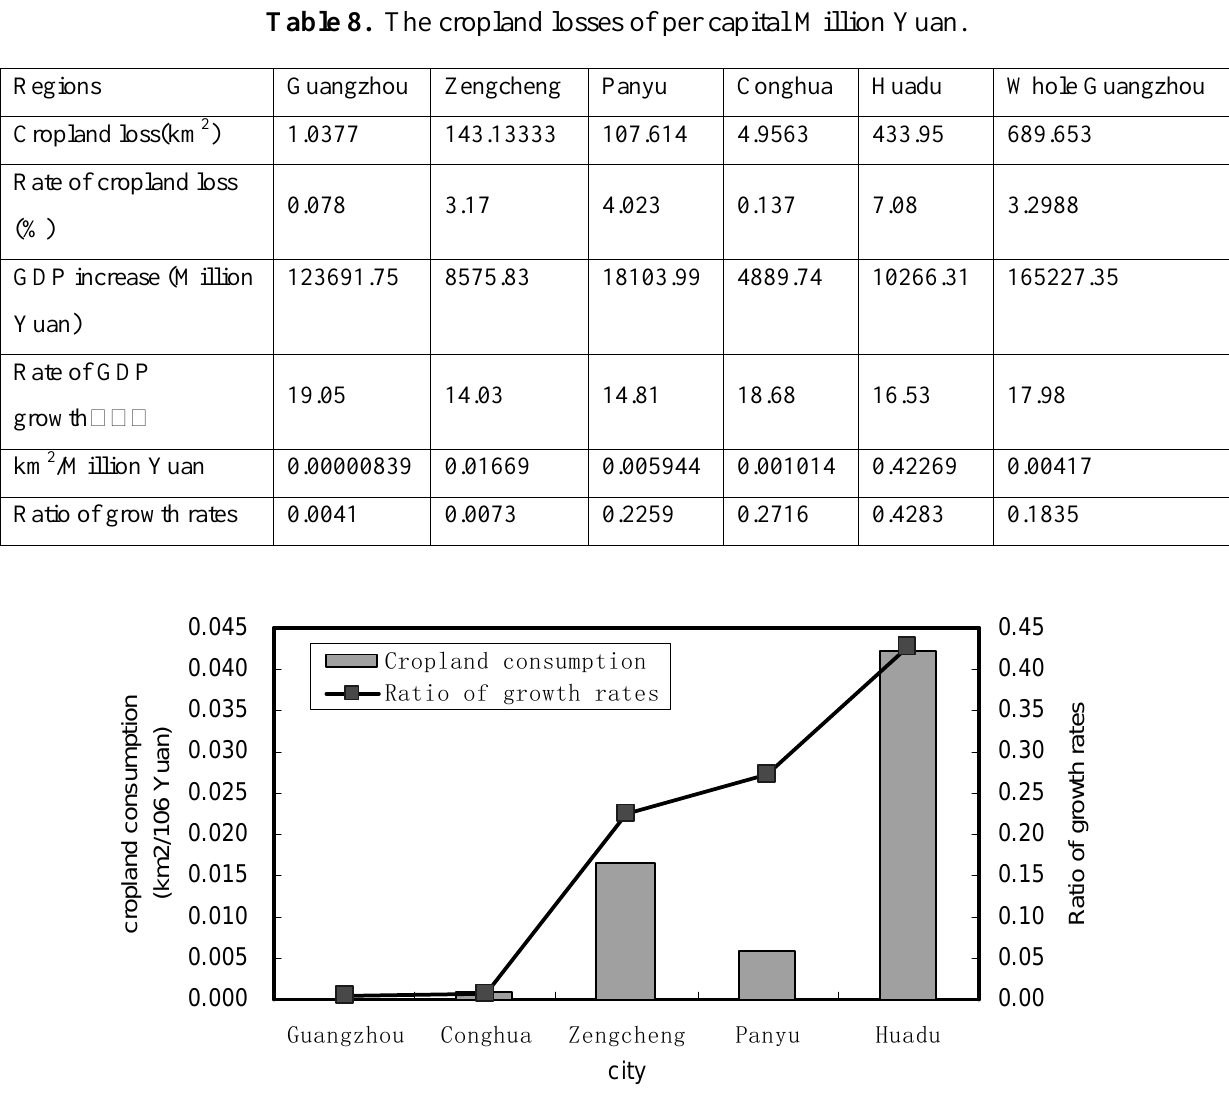
Figure 7. Comparison of the cropland consumption of per capital GDP growth and ratio of rates between cropland loss and GDP grow in Guangzhou.